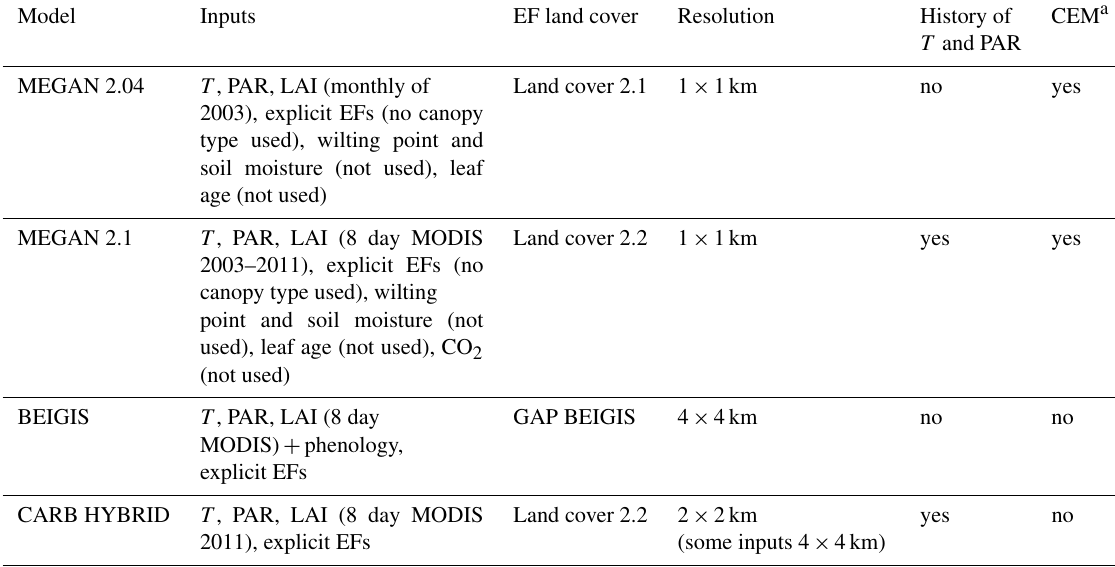
Table 1. Characteristics of each model in the regional application for CA. Model Inputs EF land cover Resolution History of CEM a T and PAR Land cover 2.1 1 × 1km yes MEGAN 2.04 T , PAR, LAI (monthly of 2003), explicit EFs (no canopy